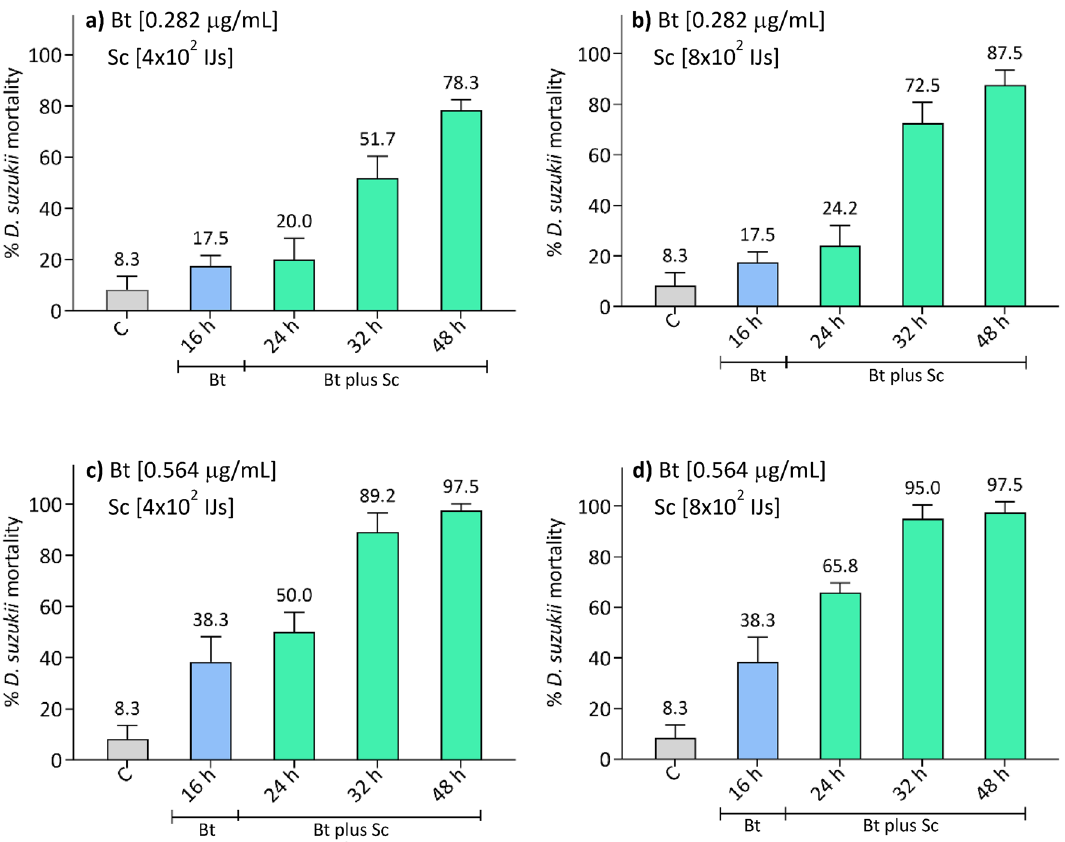
Figure 6. Mortality of D. suzukii after time-shifted administration of Bt at t 0 , plus Sc after 16 h. Graphs from ( a ) to ( d ) show the effects of different concentrations of the two entomopathogens at 16, 24, 32 and 48 h. Trials show an improvement in the effectiveness of the combination that mainly depends on the increase in Bt concentration. However, all results show a clear enhancement of the efficacy compared to assays with single administration of entomopathogens (Figs. 1 and 3). C